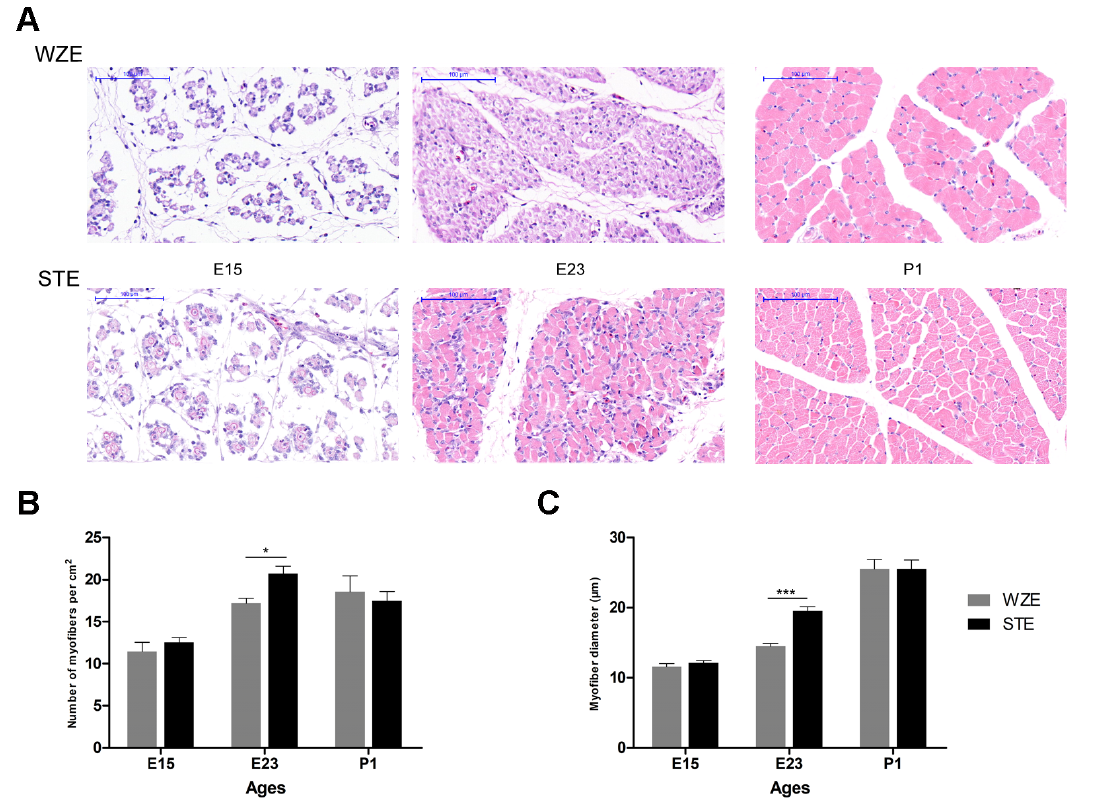
Figure 1. H&E staining results of leg muscle from STE and WZE at E15, E23, and P1. ( A ) H&E staining results of leg muscle from STE and WZE at E15, E23, and P1. ( B ) Statistical results of myofiber density (n/cm 2 ). ( C ) Statistical results of myofiber diameter ( µ m). Scale bar = 100 µ m. * p < 0.05; *** p <